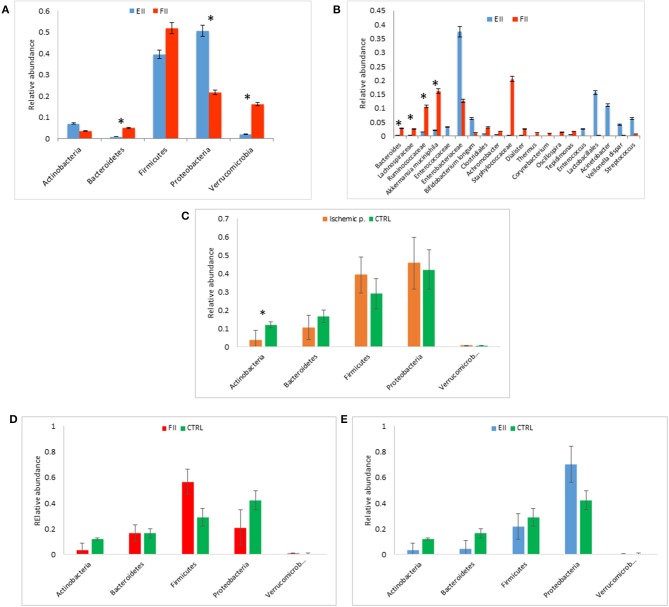
Mucosal microbiota grouped for EII and FII (A,B); FM composition at phylum level for ischemic patients (EII+FII) vs. CTRL group (C), FII vs. CTRL groups (D) and EII vs. CTRL groups (E). *p < 0.05.